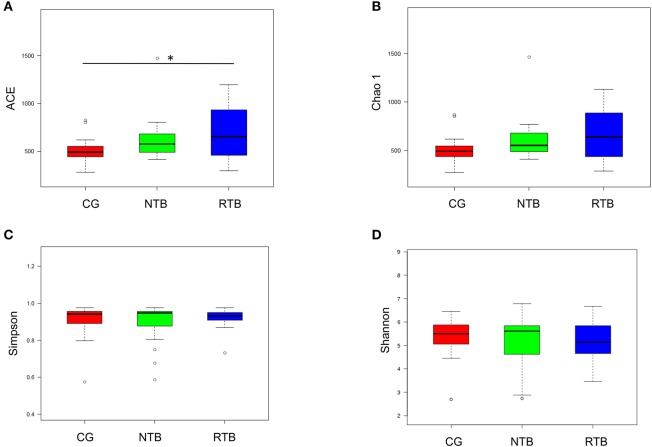
Altered biodiversity of gut microbiota in the new and recurrent tuberculosis patients in comparison with healthy control. (A,B) The new TB patients (NTB, n = 19), recurrent TB group (NTB, n = 18), and healthy human subjects, control (CG) are described in the Methods and Materials. The alpha-diversity, richness of gut microbes, was determined by ACE index and Chao1 index. (C,D) The ecological diversity of gut microbiota in the three groups of human subjects was measured by Simpson index and Shannon index. The p-values were calculated using Wilcox test. Statistical significance is displayed as *p < 0.05.